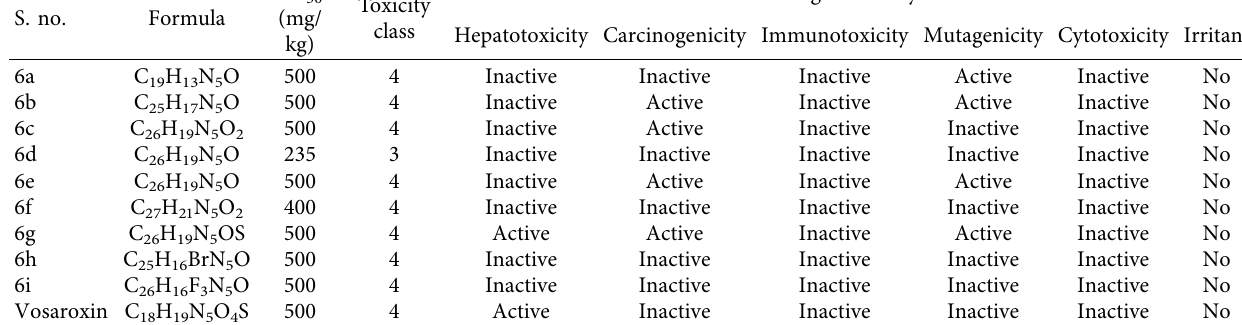
Table 8: Toxicity prediction of compounds 6a-i, computed by ProTox-II and OSIRIS property explorer. S.